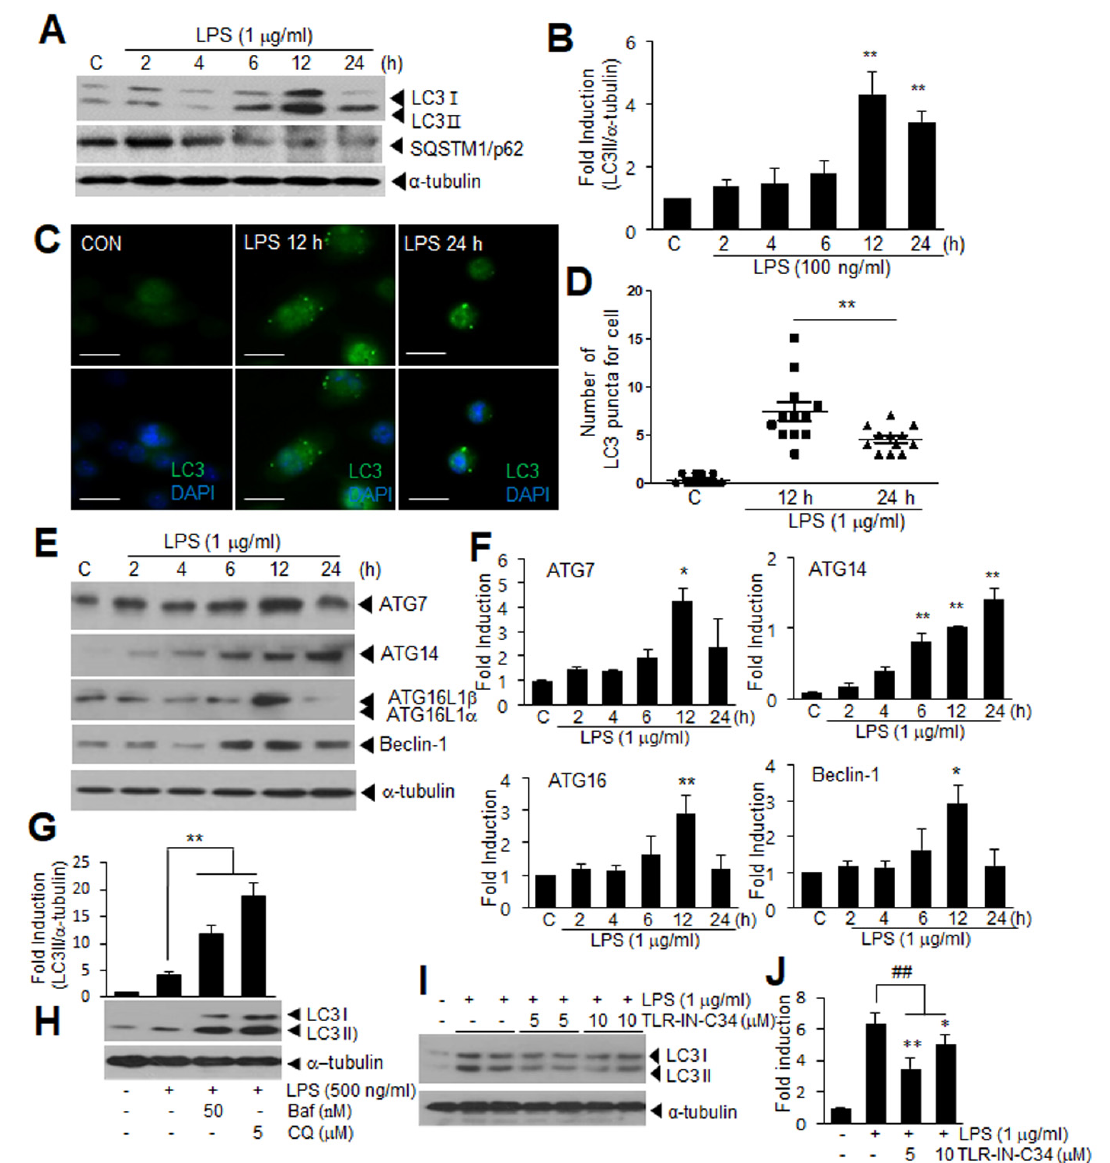
Figure 1. LPS induces autophagy in BV2 cells. BV2 cells were treated with LPS (1 µ g/mL) for 2, 4, 6, 12, and 24 h ( A – F ). ( A , B ) Protein levels of LC3 and SQSTM1/p62 were examined using immunoblotting. Representative immunoblots are presented in ( A ), and quantification results are presented as the means ± SEM in ( B ) ( n = 4); ( C , D ) Immunofluorescence staining was conducted at 12 and 24 h after LPS treatment with anti-LC3 antibody (green) and DAPI (blue). Representative images are shown in ( C ) (Scale bar, 20 µ m), and quantification of the dot– or ring–shaped LC3 signals (representing autophagosomes) are shown in ( D ) ( n = 12); ( E , F ) ATG7, ATG14, ATG16, and Beclin-1 levels were examined using immunoblotting. Representative immunoblots are presented in ( E ), and quantification results are presented as the means ± SEM in ( F ) ( n = 3 for ATG7 and ATG14, n = 4 for ATG16 and Beclin-1). ( G , H ) BV2 cells were pretreated with Bafilomycin A1 (Baf, 50 nM) or chloroquine (CQ, 5 µ M) for 2 h and then treated with LPS (500 ng/mL) for 24 h, and level of LC3 was examined using immunoblotting; ( I , J ) BV2 cells were treated with LPS (100 ng/mL) for 12 h in the presence or absence of TLR4-IN-C34 (5 and 10 µ M), and LC3 levels were examined using immunoblotting. Representative immunoblots are presented in ( H ) and ( I ), and quantification data are presented in ( G ) and ( J ) ( n = 4). * p < 0.05, ** p < 0.01 vs. PBS-treated control cells, ## p < 0.01 between indicated groups using one–way ANOVA with Student–Newman–Keuls